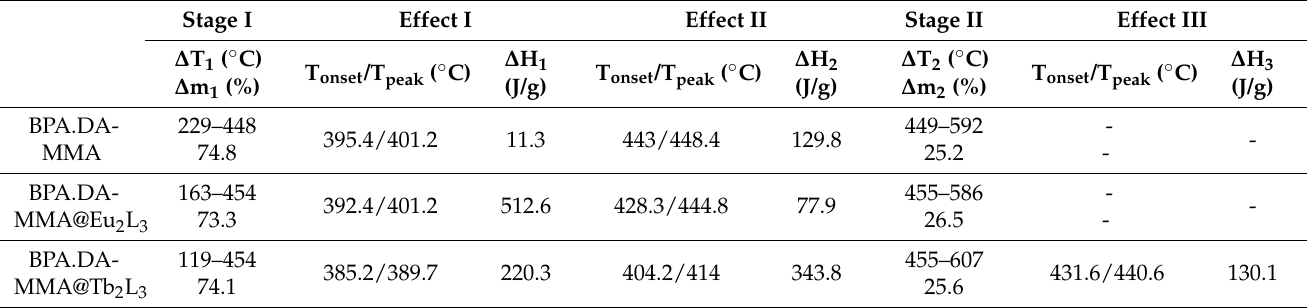
Table 1. Thermal characterization of matrix and materials (block) based on the TG-DSC curves in air.